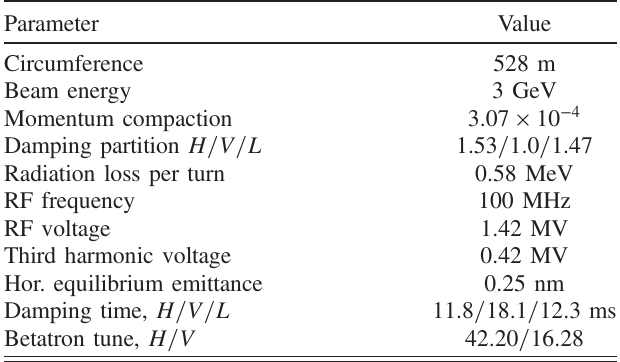
TABLE I. Parameters relevant to the longitudinal injection. Values are from our E LEGANT simulation [12].